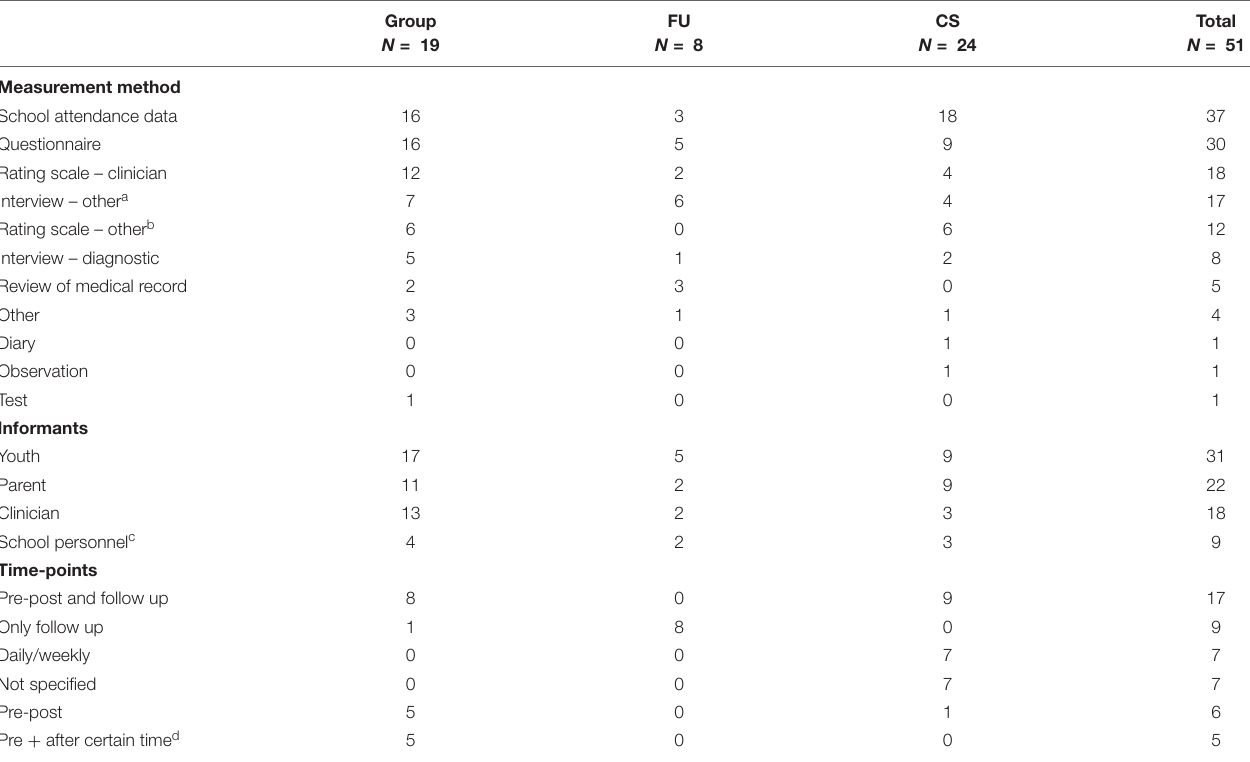
TABLE 3 | Methodological characteristics of studies evaluating outcome of intervention for school